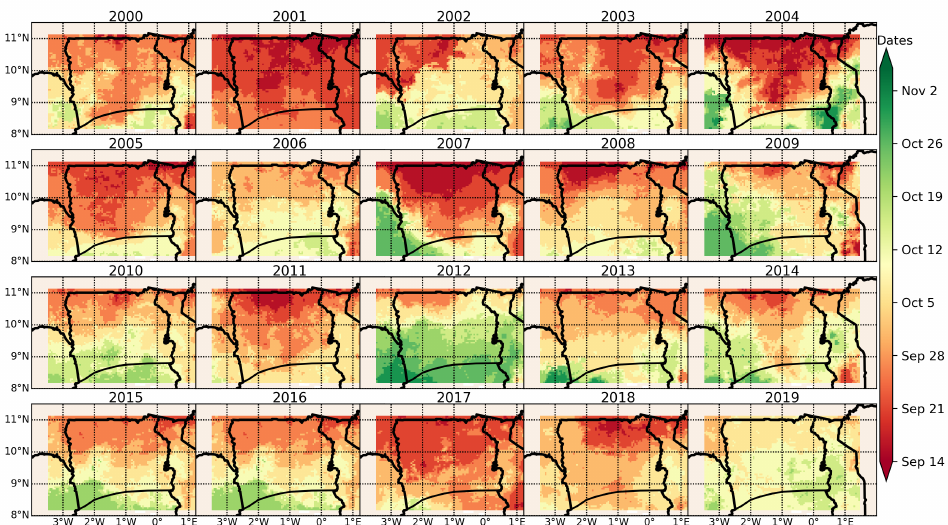
Figure 3. Maps on variability of rainfall cessations dates from 2000 to 2019 over Northern Ghana generated from